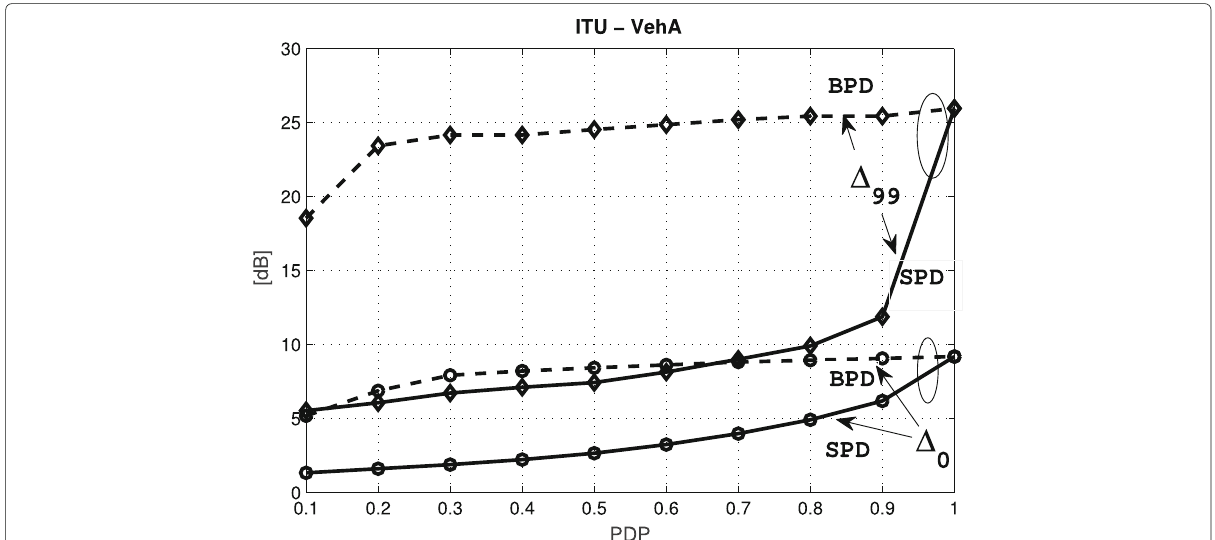
Fig. 10 Factors (cid:9) 0 and (cid:9) 99 for ITU-VehA channel model. Factors (cid:9) 0 and (cid:9) 99 vs. PDP for ITU-VehA channel model. Continuous lines refer to the results obtained with the SPD strategy while dotted lines are obtained with the BDP